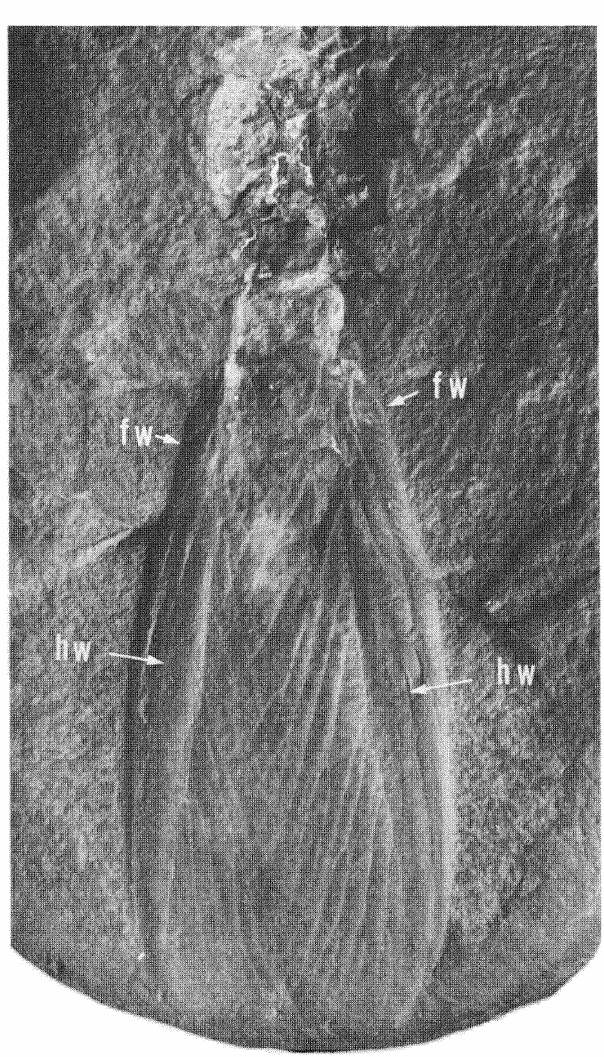
Fig. 13. Gerarus coilaris, photograph of holotype, Y PM 34. Length of fore wing 48 mm. fw fore wing; hw hind